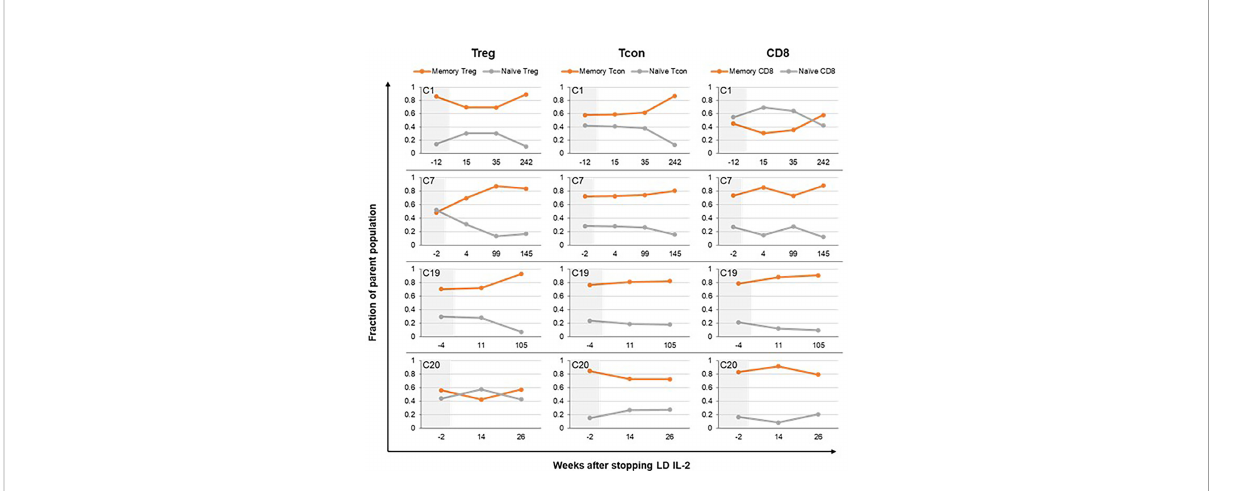
FIGURE 3 Impact of IL-2 discontinuation on naïve and memory T-cell compartments. Naïve and memory subsets within each of the T cell parent populations (CD4+ Treg, CD4+ Tcon, and CD8+ T cells) are shown. The fraction of naïve T cells within Treg, Tcon, and CD8+ T-cells over time is represented by orange lines. The fraction of memory T cells within the various T cell subtypes is represented by gray lines. The memory fraction includes effector memory, central memory, and TEMRA T cells. Patient C1, C7, and C19 had the longest follow up period with available immune cell data. Patient C20 is shown as representative data for patients with shorter follow up times. The time period prior to IL-2 discontinuation is shaded in light gray. Treg, CD4+ regulatory T cell; Tcon, CD4+ conventional T